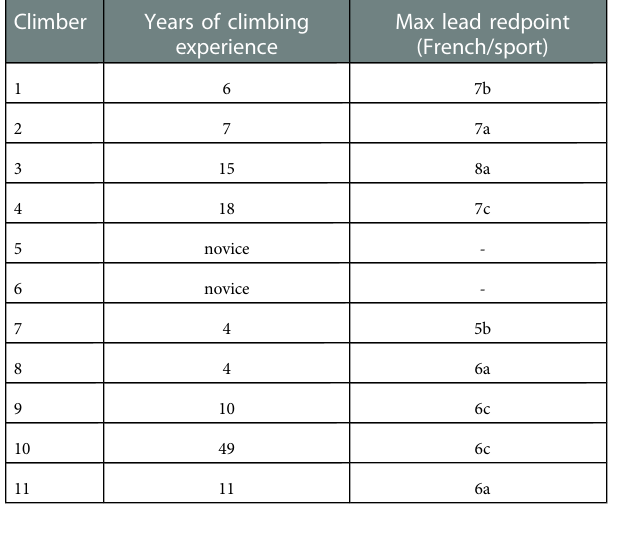
TABLE 2 Climbers who participated in the test: years of climbing experience and maximum redpoint grade in the last 3 years. Climber Years of climbing experience